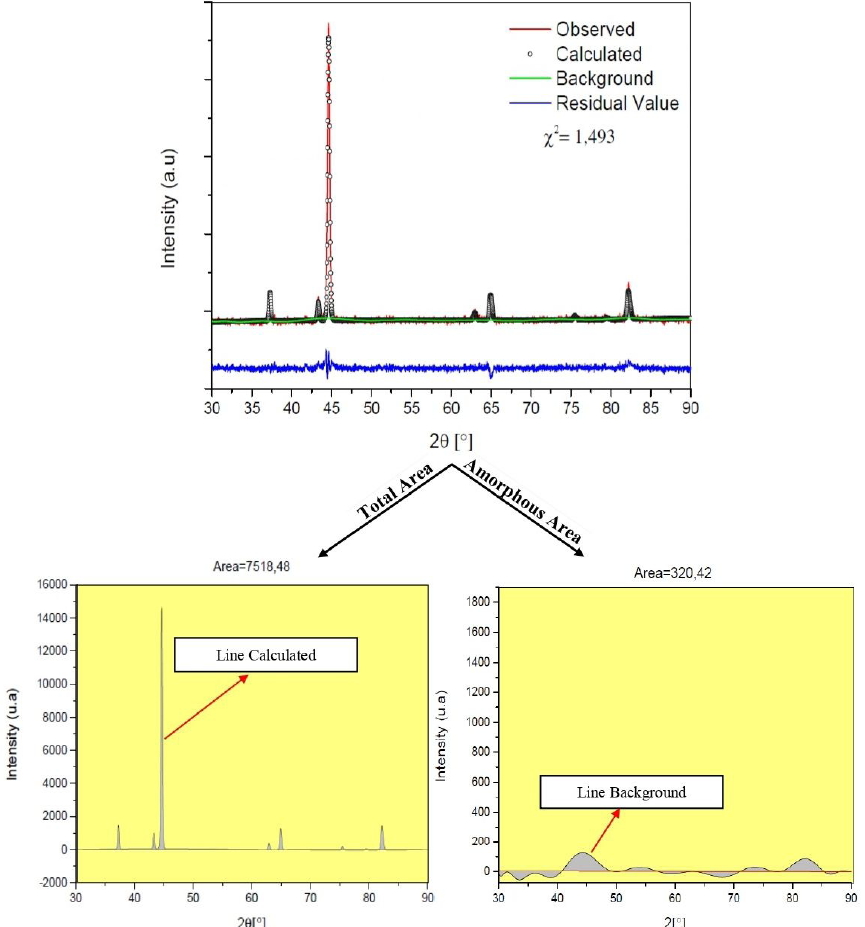
Figure 14: Refinement and obtainment of the curves to calculate the percentual estimation of crystallinity (sample as received)